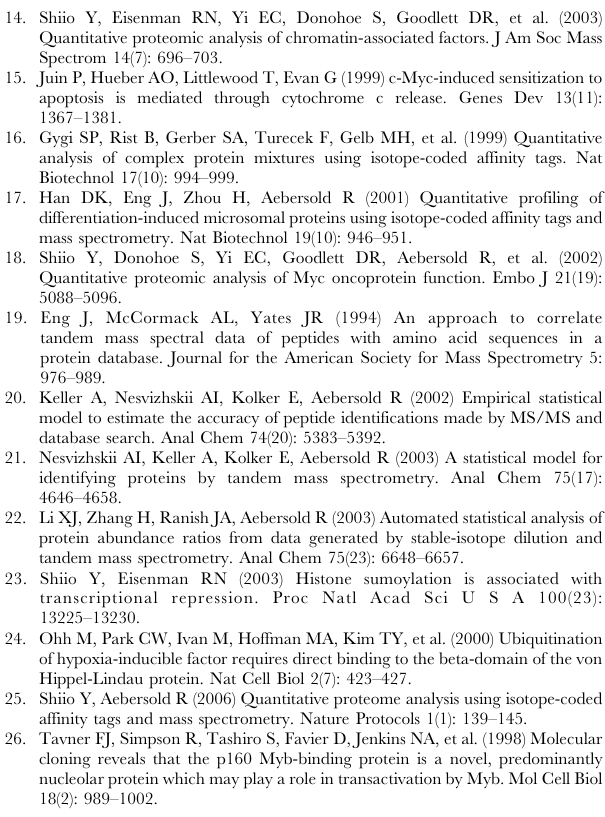
Table S2 List of proteins displaying more than 2-fold reduction upon iron chelation. The list of proteins induced or reduced by more than 2-fold upon iron chelation is available as ‘list of proteins induced by iron chelation.xls’ and ‘list of proteins reduced by iron chelation.xls’ files, respectively. These datasets contain proteins with ProteinProphet probability score $ 0.5.